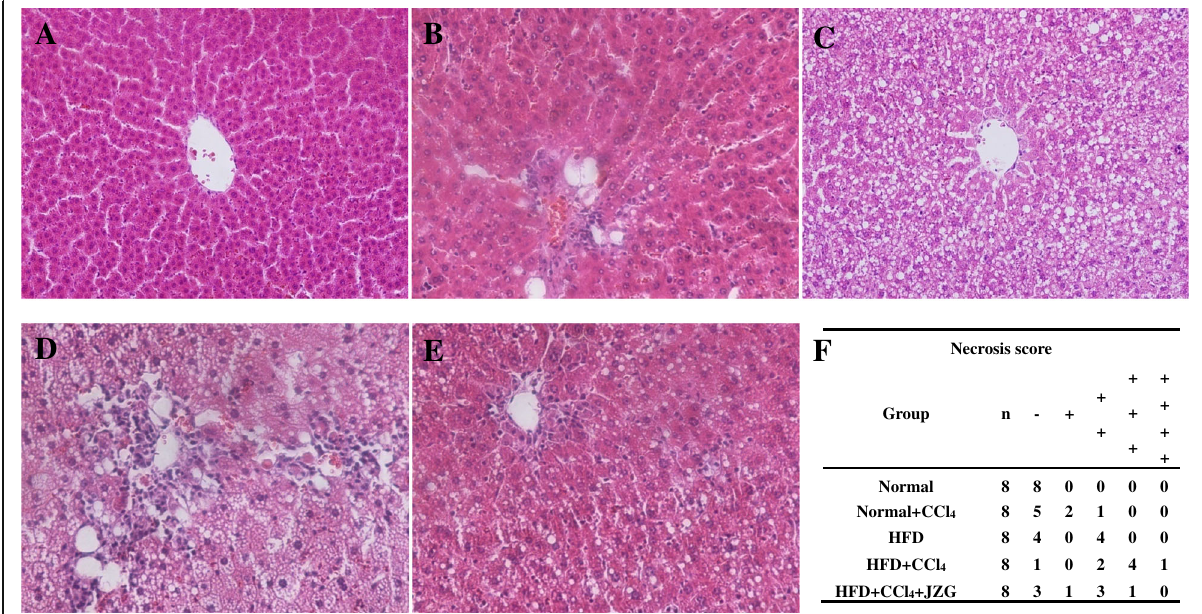
Fig. 1 Effect of JZG on the histopathology of liver tissues of rat: a - e HE staining of liver tissue, the original magnification is 200×, a Normal group, b Normal+CCl 4 group, c HFD group, d HFD + CCl 4 group, e HFD + CCl 4 + JZG group, f Necrosis score of liver